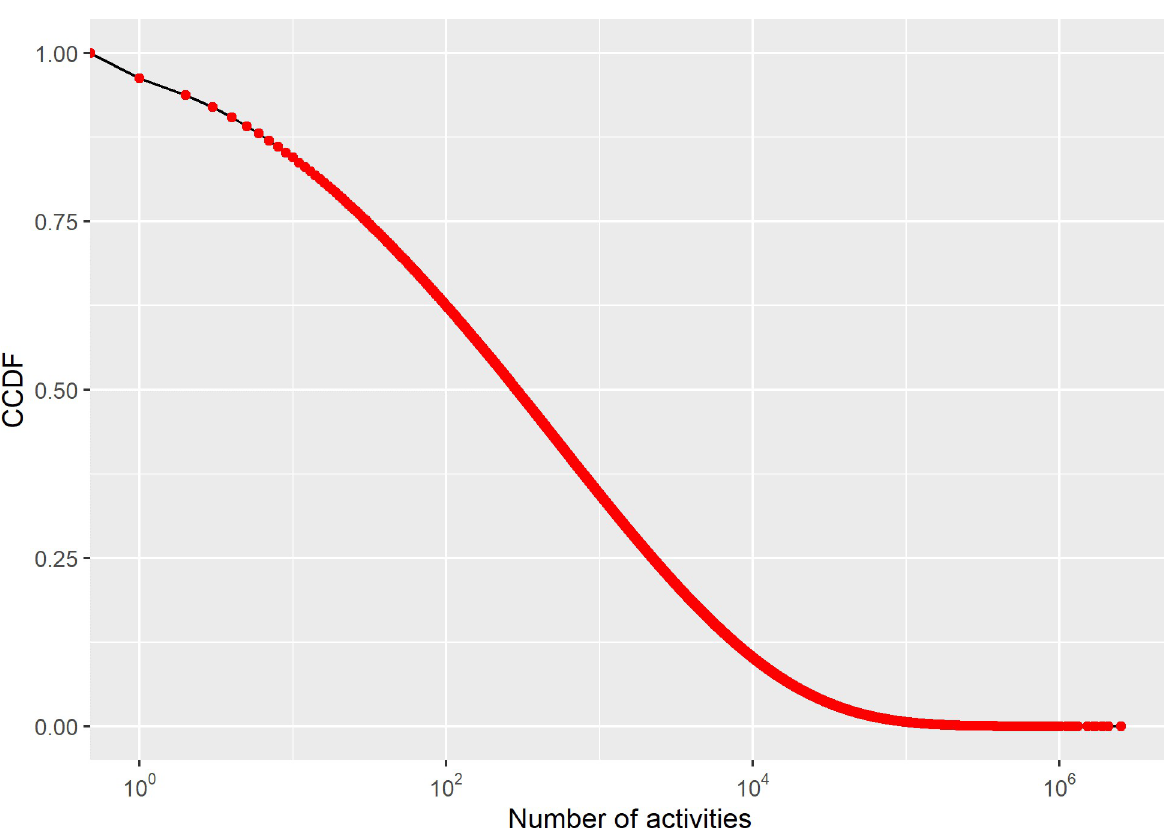
Fig 6. Semi-log plot of the complementary cumulative distribution functions of the number of tweets per user.